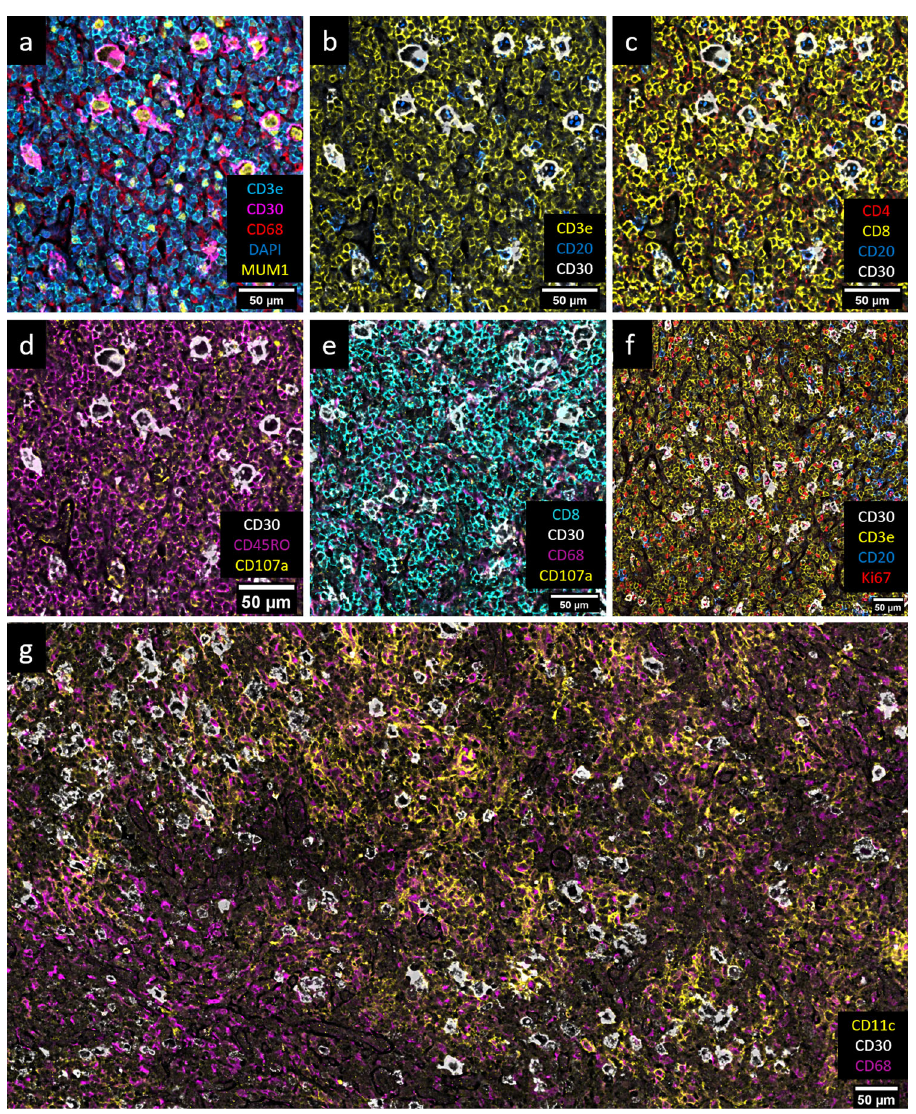
Fig. 4 Additional images of classic Hodgkin lymphoma demonstrating the various stains performed. a CD30 = magenta, MUM1 = yellow, DAPI = blue, CD3e = cyan, CD68 = red. b CD30 = white, CD3 = yellow, CD20 = blue. c CD30 = white, CD8 = yellow, CD4 = red, CD20 = blue. d CD30 = white, CD107a = yellow, CD45RO = magenta. e CD30 = white, CD68 = magenta, CD107a = yellow, CD8 = cyan. CD107a is seen variably expressed in CD68 + histiocytes. CD107a puncta are also seen in association with CD8 + cells, though some other puncta are also seen which are of uncertain signi fi cance and might indicate non-speci fi c staining. f CD30 = white, CD3e = yellow, CD20 = blue, Ki67 = red. g CD30 = white, CD68 = magenta, CD11c = yellow. CD11c expression is distributed in a patchy manner in the imaged tissue and primarily found in region 2 (compare with Supplementary Fig. 10; a CD11c rich area is shown here) and associated more frequently with helper T cells and histiocytes. Images were created using the Akoya CODEX MAV plugin for